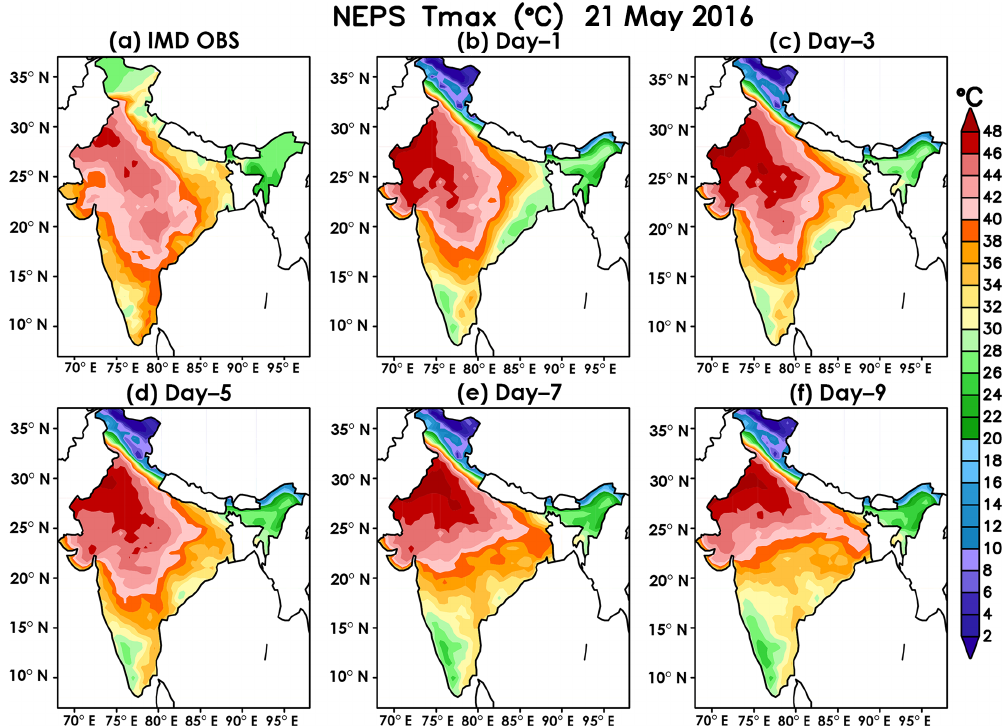
Figure 8. Spatial distributions of observed T max (a) and NEPS forecast T max (b–f) prevailing heatwaves over Rajasthan, MP, UP, Delhi, Haryana, Punjab and some parts of Maharashtra on 21 May 2016 (NEPS stands for NCMRWF ensemble prediction system; observed data from India Meteorological Department and forecast data from NCMRWF). Observed (a) T max ≥ 40 ◦ C is widespread over north-western and central India. NEPS forecasts (b–f) show a similar distribution. However, the forecasts indicate much stronger warming compared to the observations. The T max ≥ 46 ◦ C is confined to a small region in the observations, while in the NEPS forecasts it is widespread over north-western India. Additionally, in NEPS day 7 and day 9 forecasts (e, f) T max ≥ 40 ◦ C does not extend to over the peninsula and is seen stretching eastwards compared to the observations (a) .